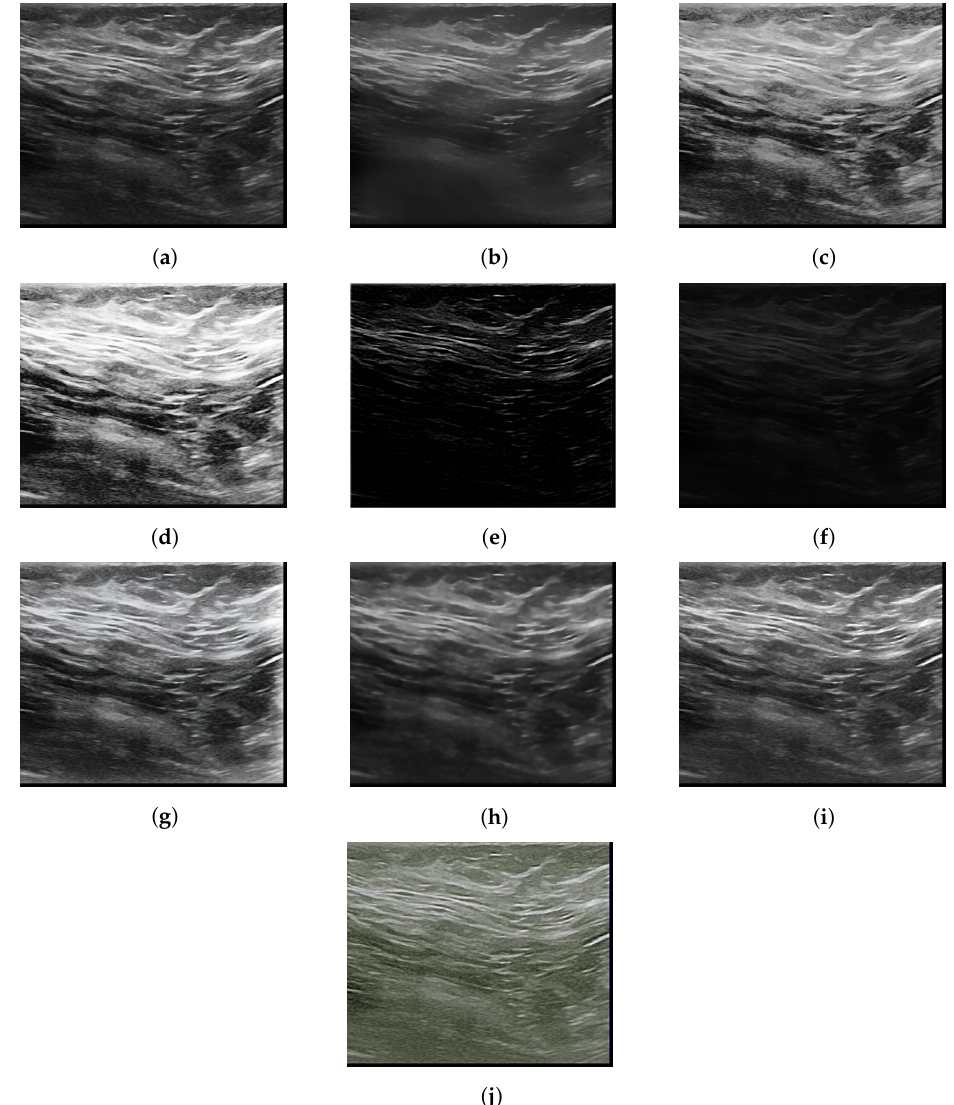
Figure 4. Normal highlighted mammogram images ( a ) Original ( b ) Bilateral ( c ) Gamma